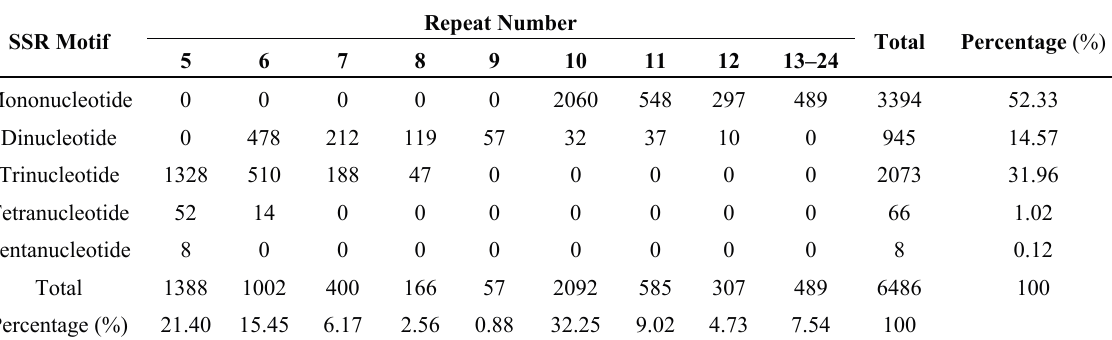
Table 1. Frequencies of the different SSR repeat motif types observed in the Welsh onion